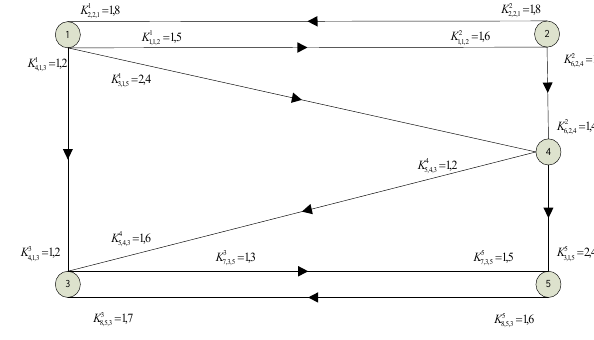
Figure 3: The calculation scheme of the transport network and rail traflc volumes for example of solving the mathematical model of the optimal RFID readers’